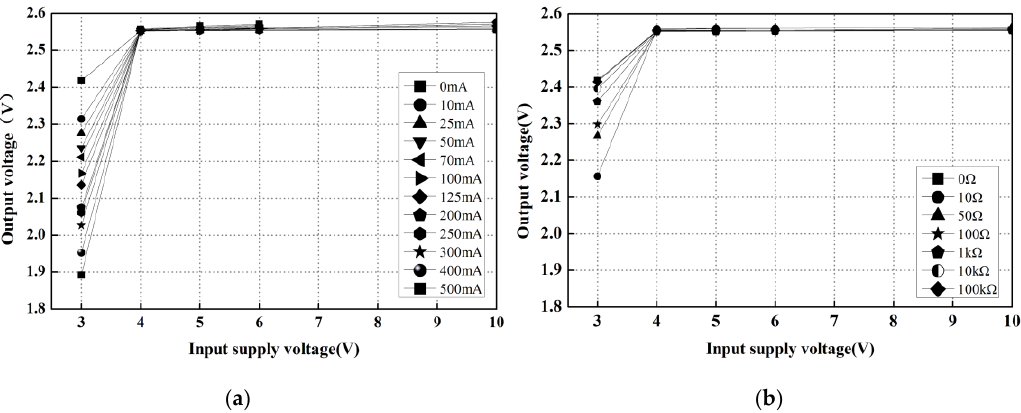
Figure 11. Measured output voltage versus input supply voltage ( a ) with different current loads and ( b ) with different resistance loads.